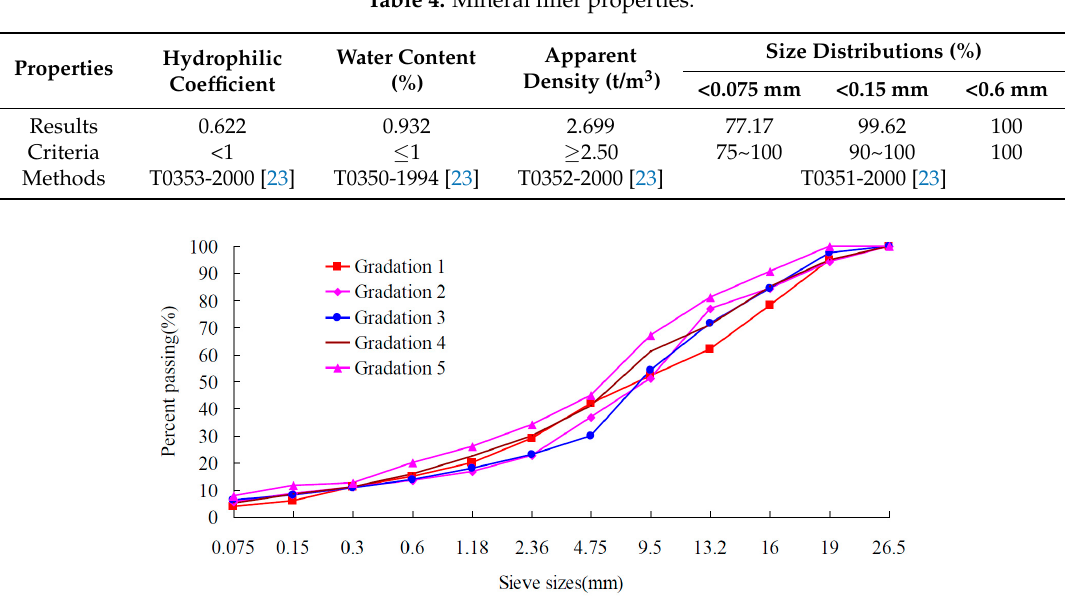
Figure 1. Aggregate gradations.